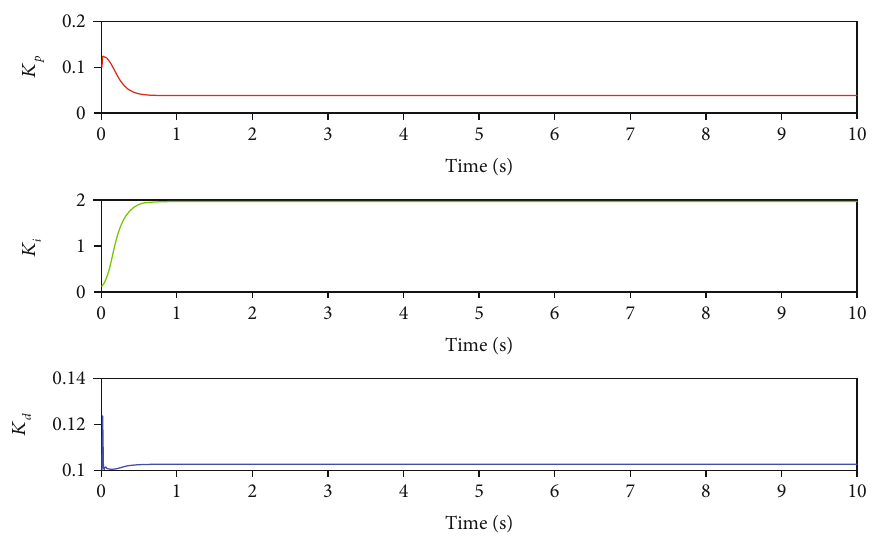
Figure 10: Intelligent adjustment output of parameters K